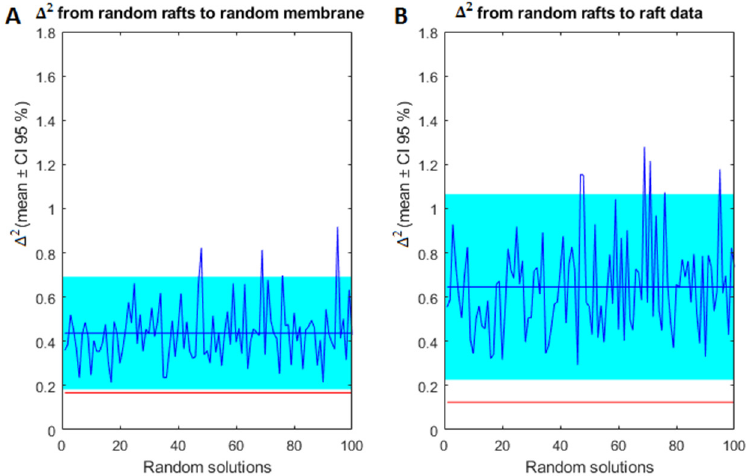
Figure 3. Analysis of results from Figure 2. ( A ) between the random generated cell membrane lipid composition and the corresponding simulated lipid raft composition. ( B ) ∆ 2 between lipid raft com- positions presented in panel A and the experimental lipid raft composition (straight blue line rep- resents the mean value and the blue rectangle represents the CI 95 %). Red lines indicate the ∆ 2 between the lipid raft composition shown in Figure 2D, and the frontal cortex lipid raft composition (Figure 2B).